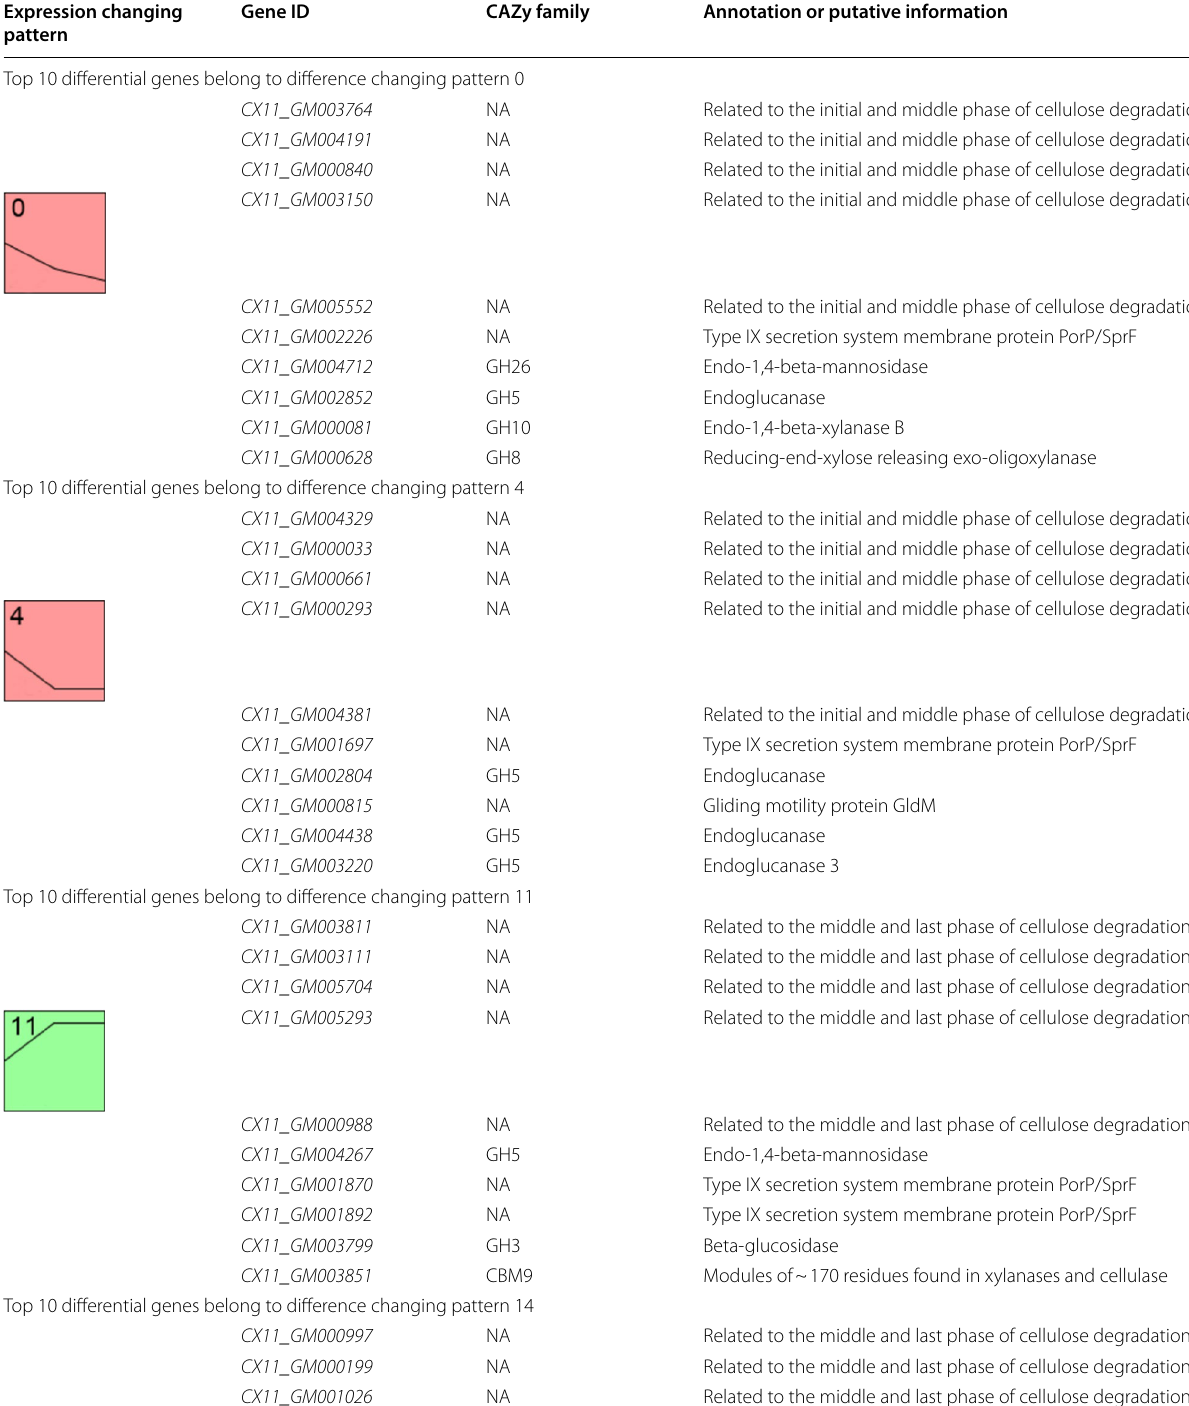
Table 2 Differentially expressed genes belong to 4 different expression patterns Expression changing